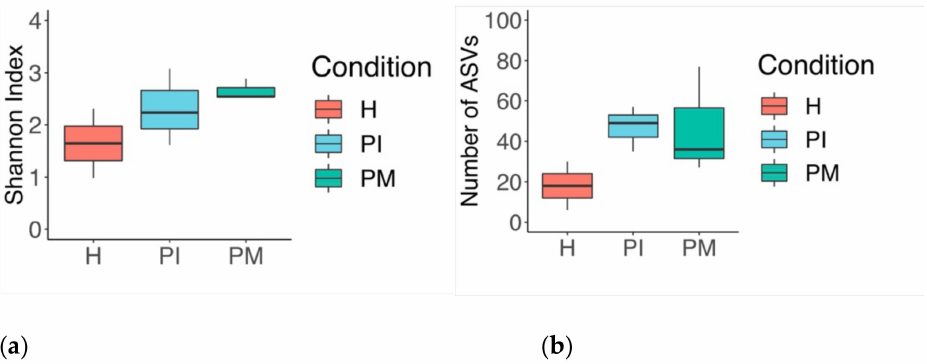
Figure 2. Steady-state biofilm boxplot (Tukey): ( a ) number of amplicon sequence variants (ASVs) showing the number of unique features detected in each sample, and ( b ) the Shannon index showing the degree of evenness between unique features (distributed within the community proportionality); increased richness and diversity found in the disease